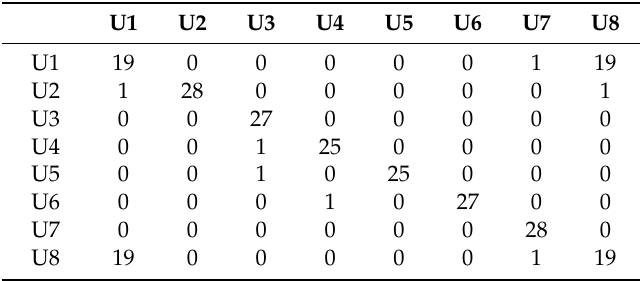
Figure7. ComparisonofuserrecognitionaccuraciesobtainedbytheRFclassifierforthePAMAP2dataset with and without feature selection. Table 6. Confusion matrix of user identification for the Nordic walking activity in PAMAP2